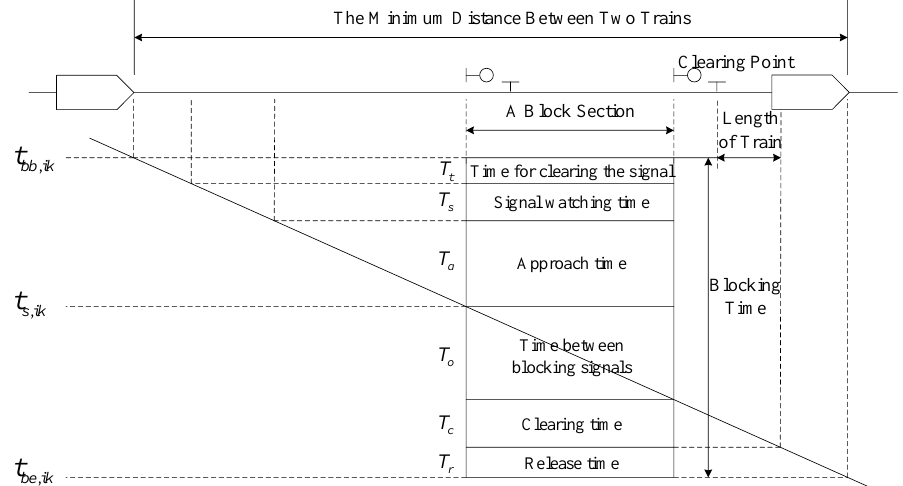
Figure 3. Diagram of the composition of the blocking time for a train without a scheduled stop.